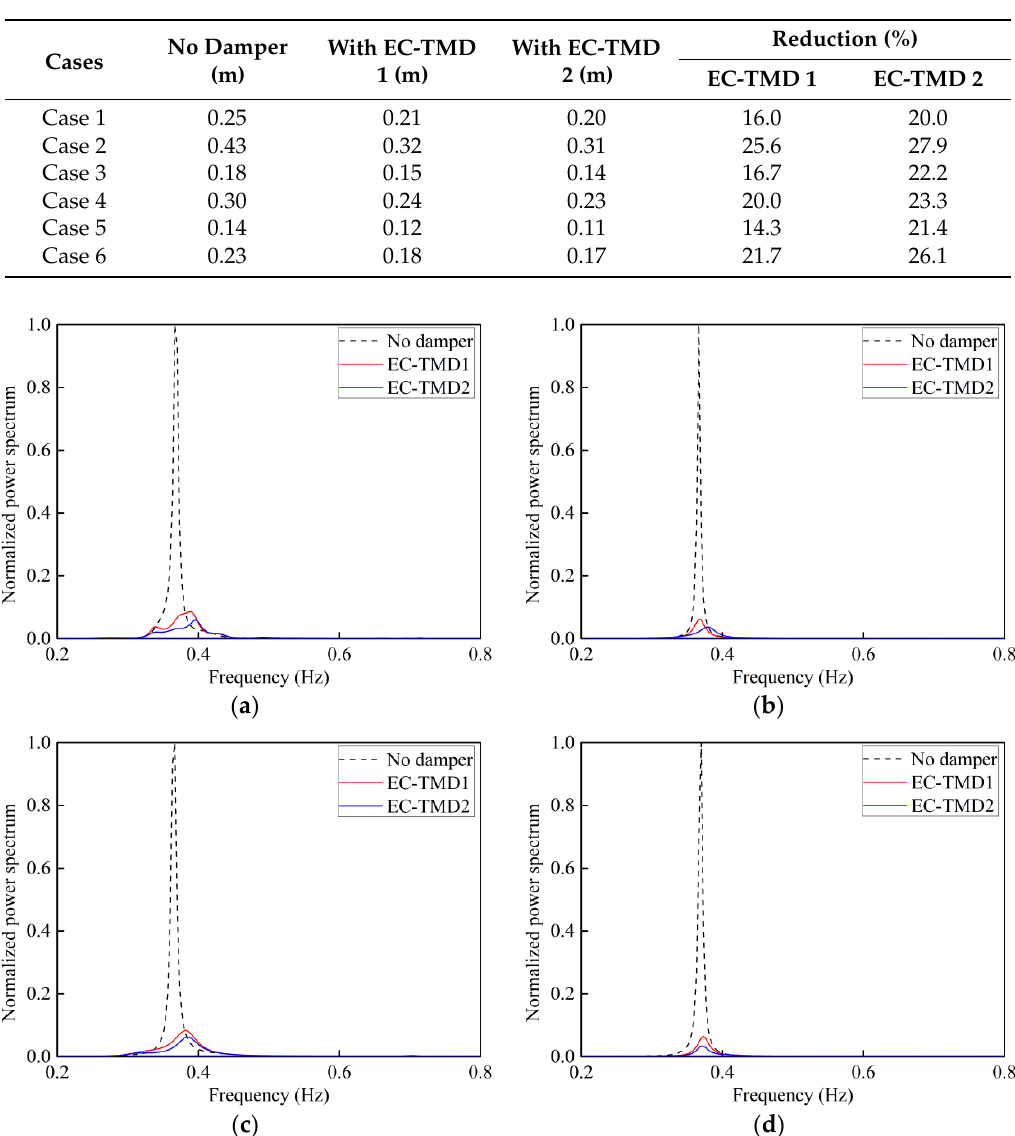
Table 8. RMS values of displacements at the tower top for different cases.